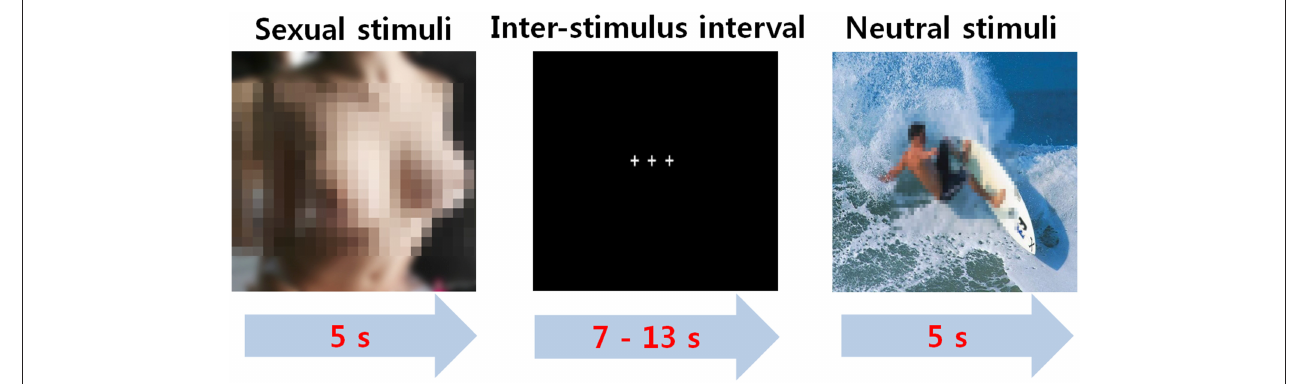
FIGURE 1 | The event-related paradigm for sexual